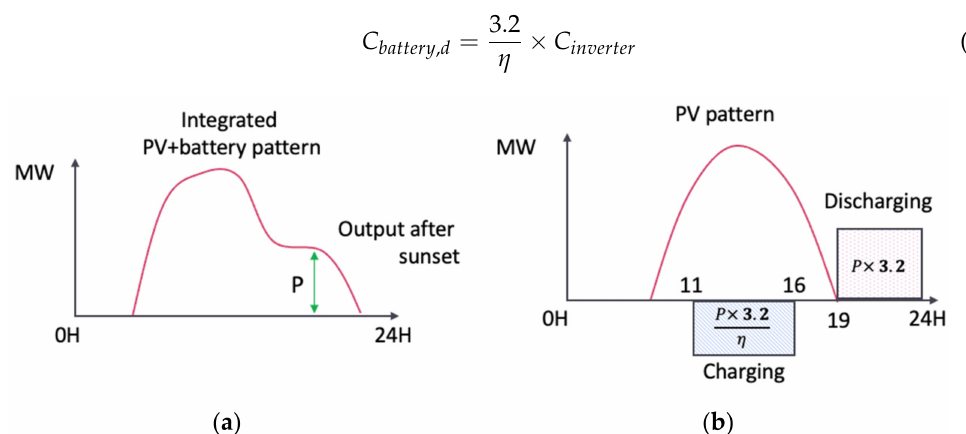
Figure 6. Capacity estimation for inverter (MW) and battery (MWh). ( a ) shows the observed FTM pattern and the amplitude used to find inverter, and ( b ) shows the following estimation